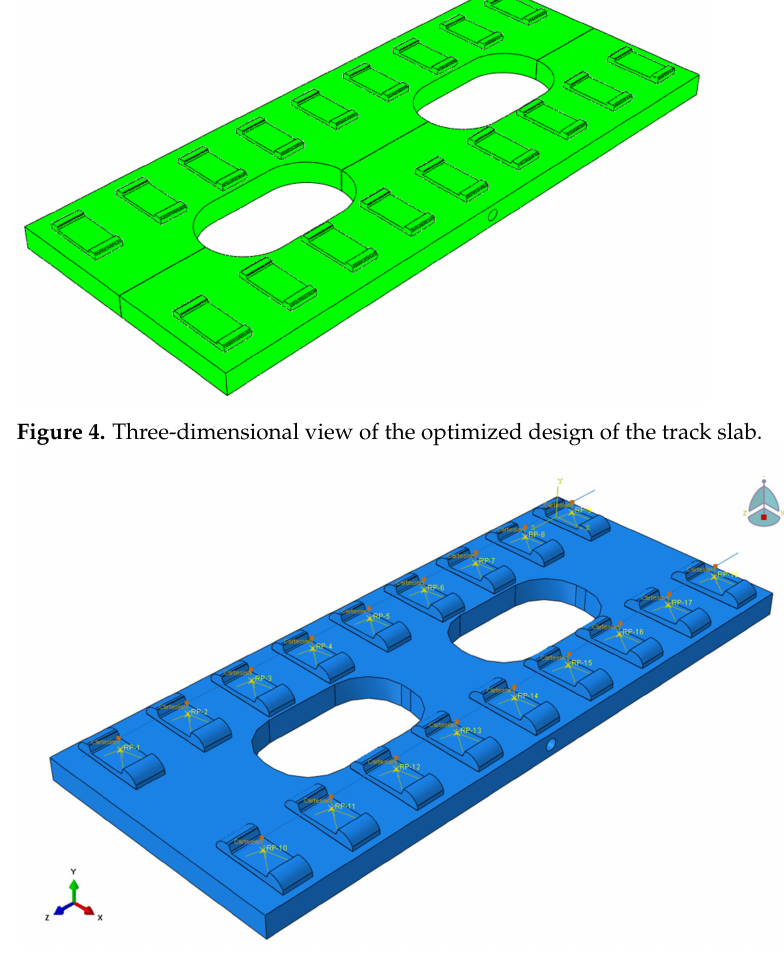
Figure 5. The finite element model of the NFTBT’s structure.